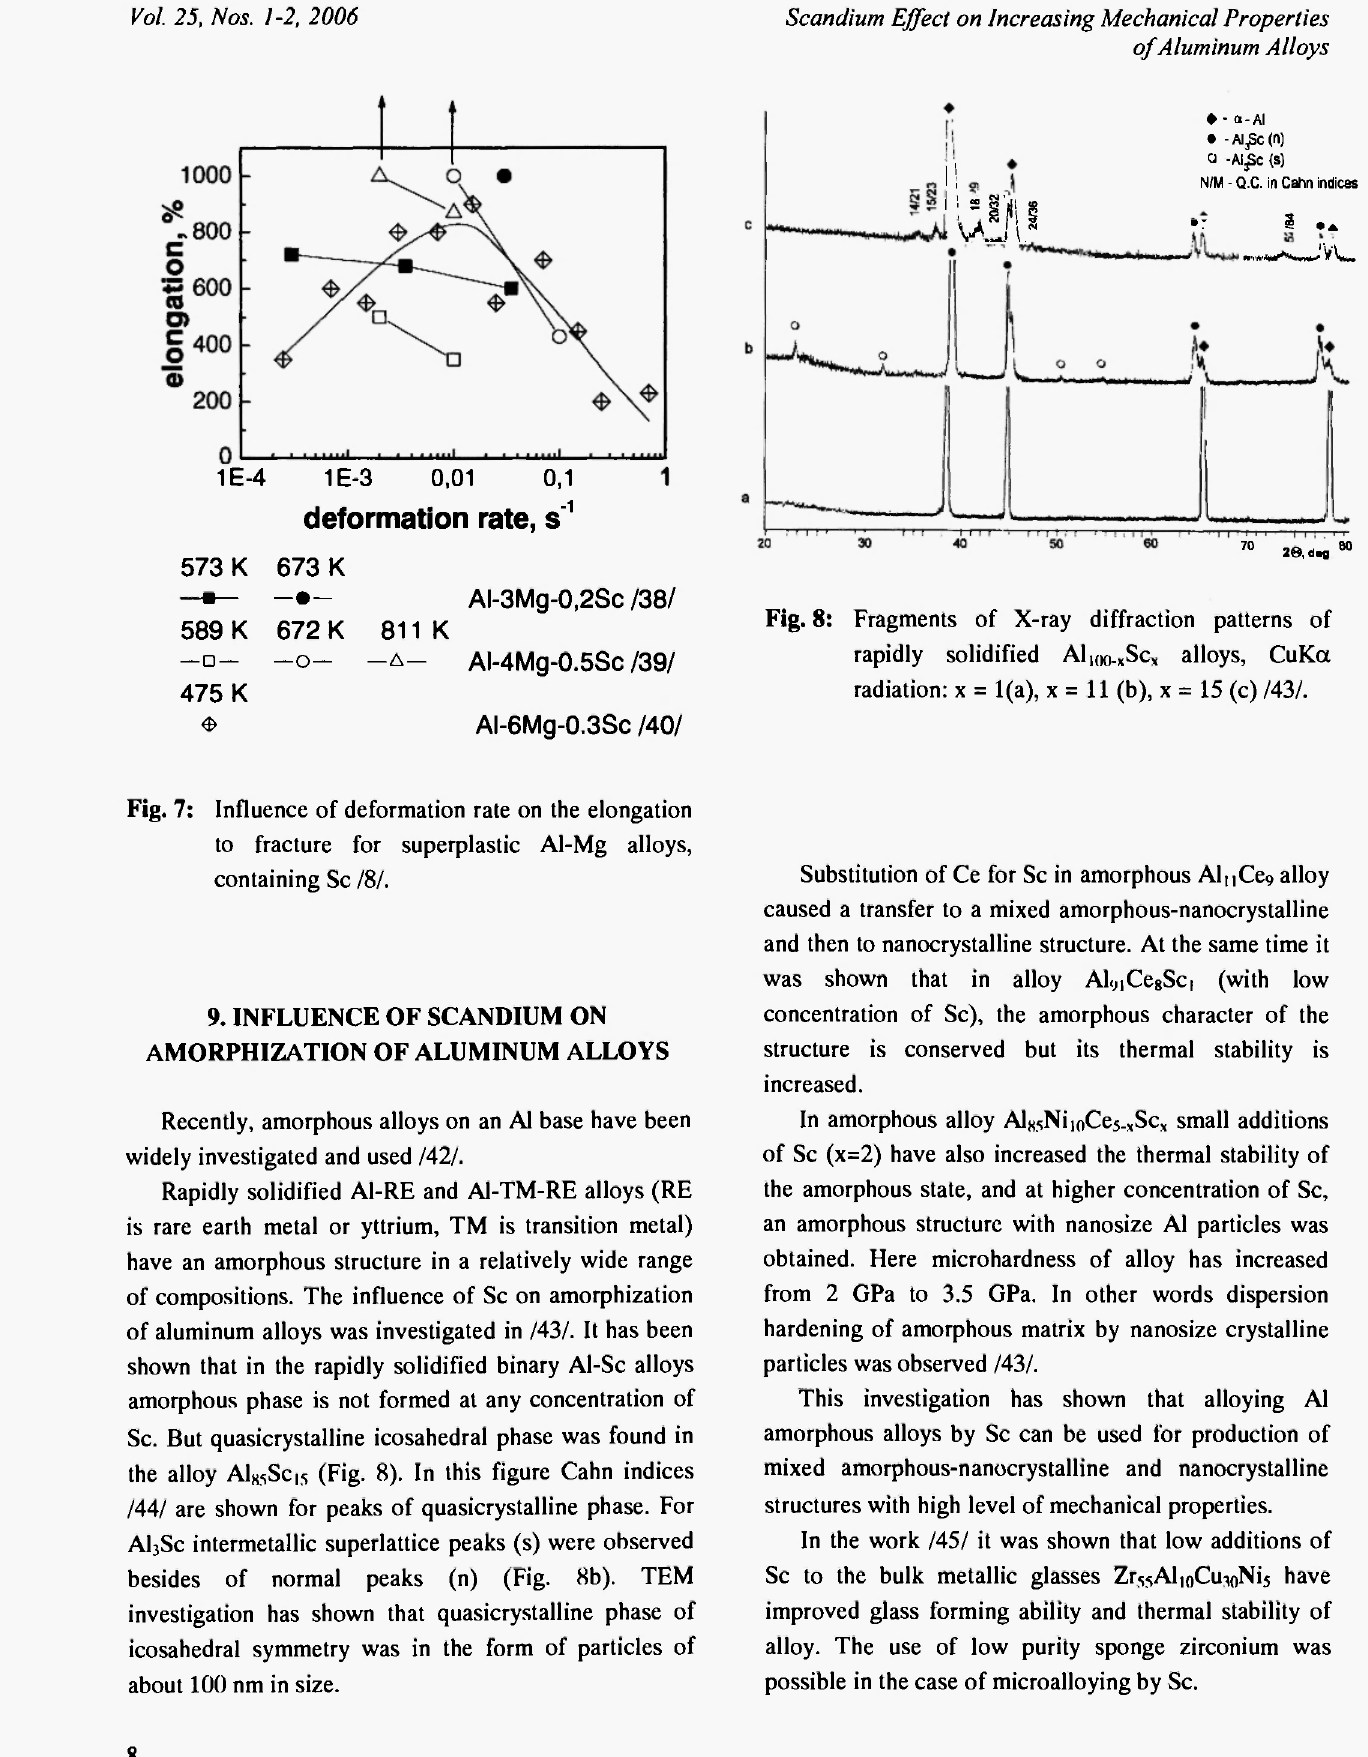
Fig. 7: Influence of deformation rate on the elongation to fracture for superplastic Al-Mg alloys, containing Sc